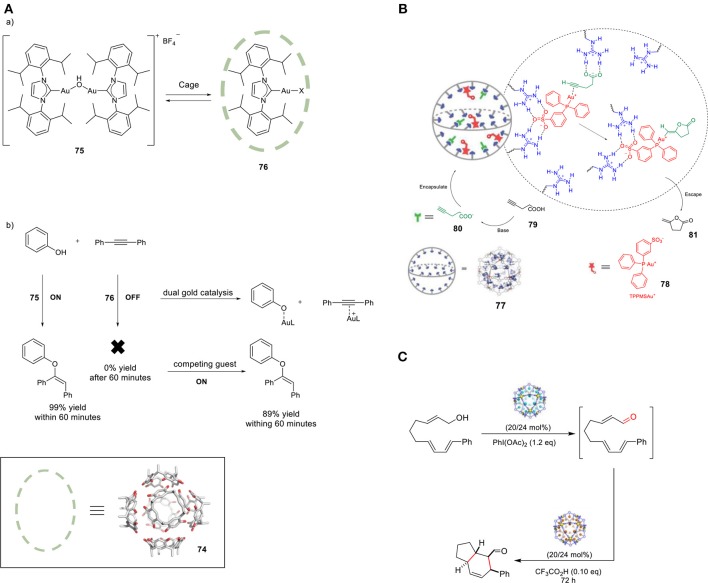
(A,a) Encapsulation of [{Au(IPr)}2(μ-OH)](BF4) in hexameric resorcin[4]arene cage. (b) Switching the gold-catalyzed hydrophenoxylation off and on. (B) Schematic representation of the base-triggered catalytic gating process. (C) Self-Assembled molecular containers for catalyst isolation enabling two-step cascade reactions. Reproduced with permission from Ueda et al. (2017).